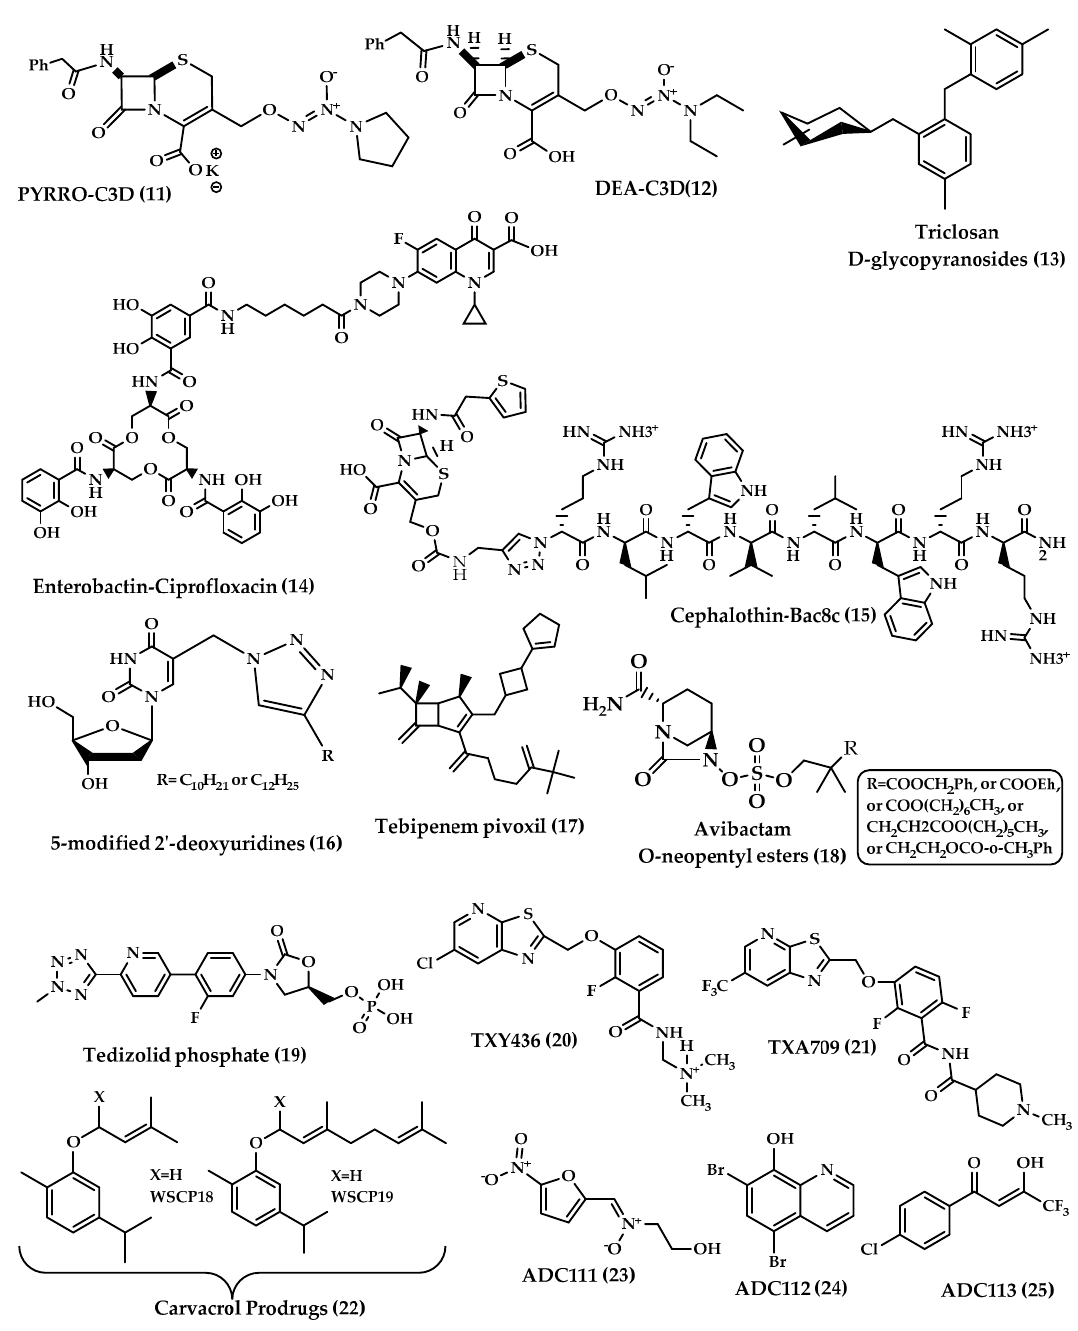
Figure 6. Chemical structures of 11 – 25 .